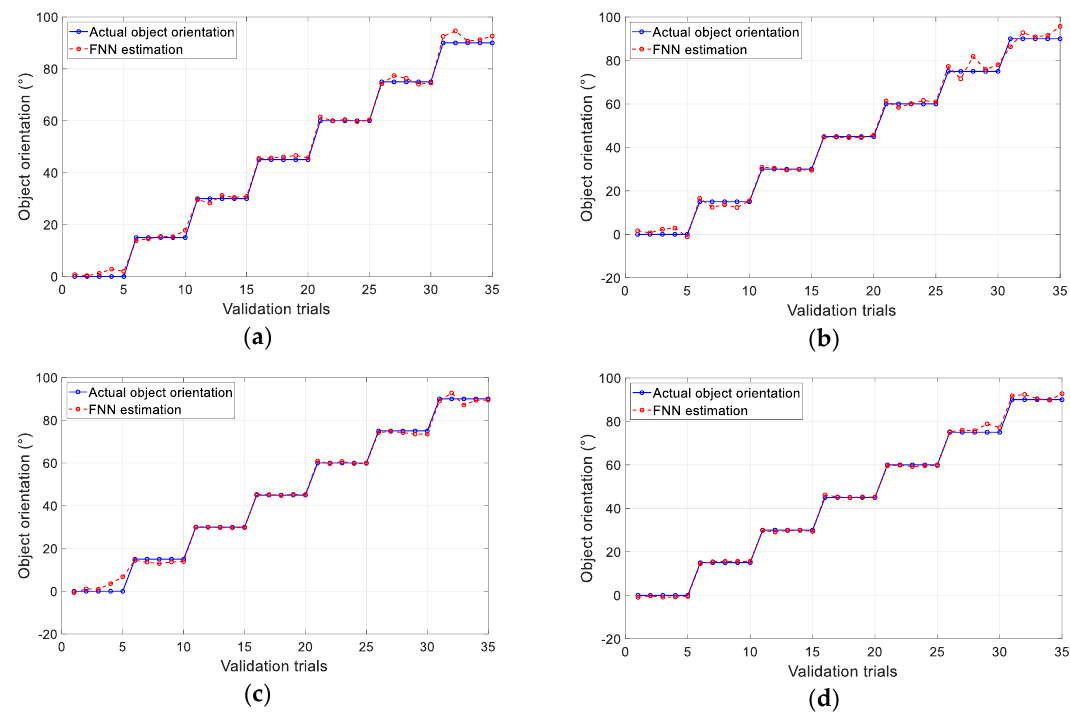
Figure 12. Results of five validation trials for each object orientation using FNN for each design: ( a ) Design A, ( b ) Design B, ( c ) Design C, and ( d ) Design D.